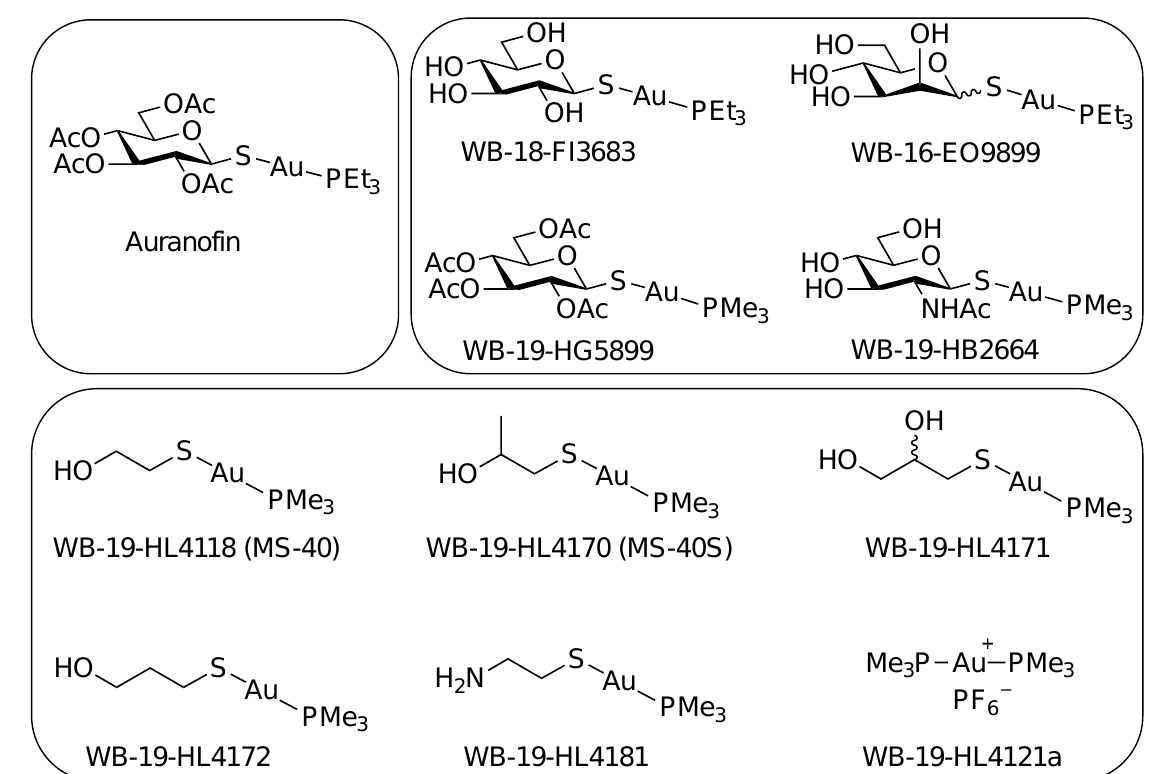
Figure 1. Chemical structure of auranofin and auranofin analogs. ( Top left ) Auranofin. ( Top right ) Group one auranofin analogs containing modifications of the thioglucose and replacement of triethylphosphine (P(CH 2 CH 3 ) 3 ; PEt 3 ) with trimethylphosphine (P(CH 3 ) 3 ; PMe 3 ). ( Bottom ) Group two auranofin analogs, contains mercaptoethanol (OHCH 2 CH 2 SH) replacing the thioglucose, then further modifications of mercaptoethanol. Table 1. Minimum inhibitory concentrations (MICs) of group two auranofin derivatives against Burkholderia cepacia complex (Bcc) bacteria, B. mallei and B. pseudomallei